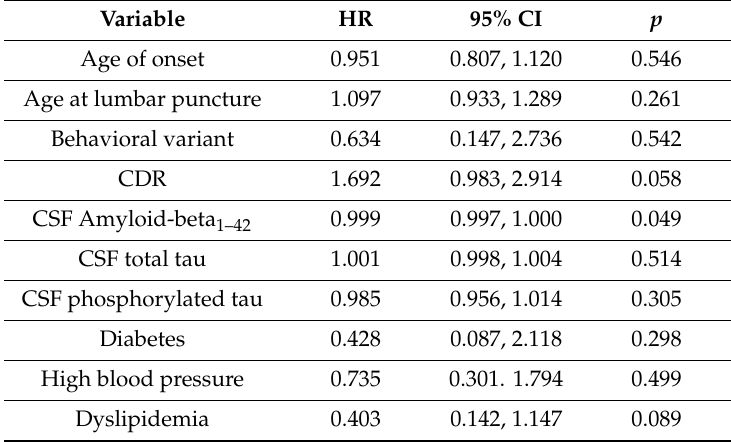
Table 2. Cox regression results of the variables associated with the death rate ( γ 2 = 18.799, df = 10, p = 0.043, − 2 log likelihood =